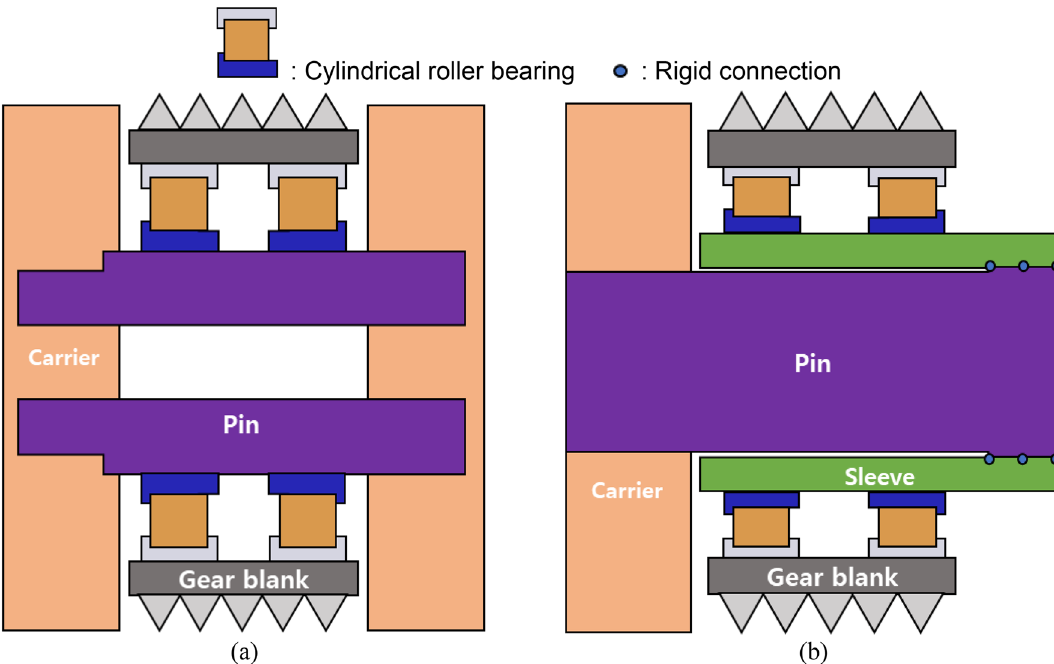
Figure 4. Schematics of the planet structure: ( a ) a conventional straddle-mounted pin, and ( b ) a flexible